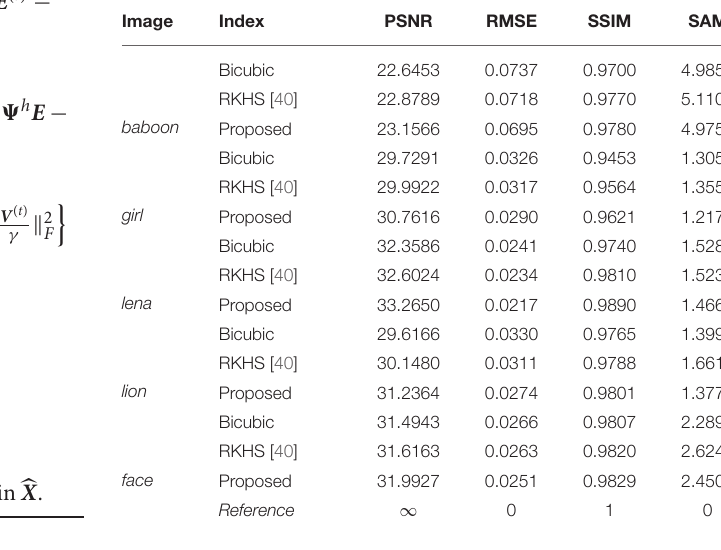
TABLE 1 | Quantitative Results with for single image super-resolution with ω =